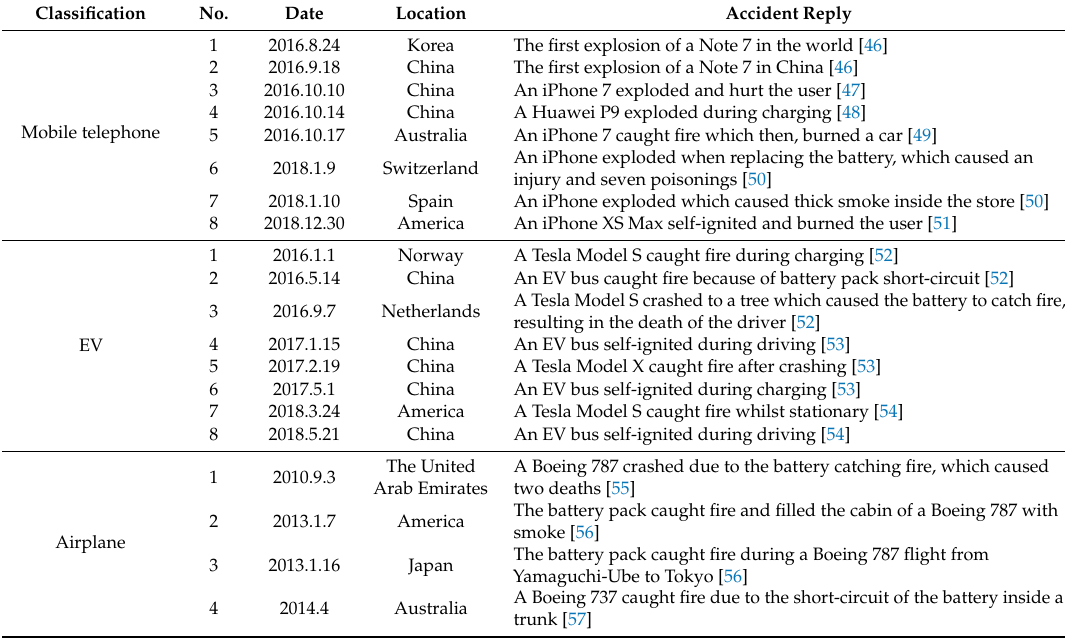
Table 1. Selected incidents of lithium-ion battery failure in recent